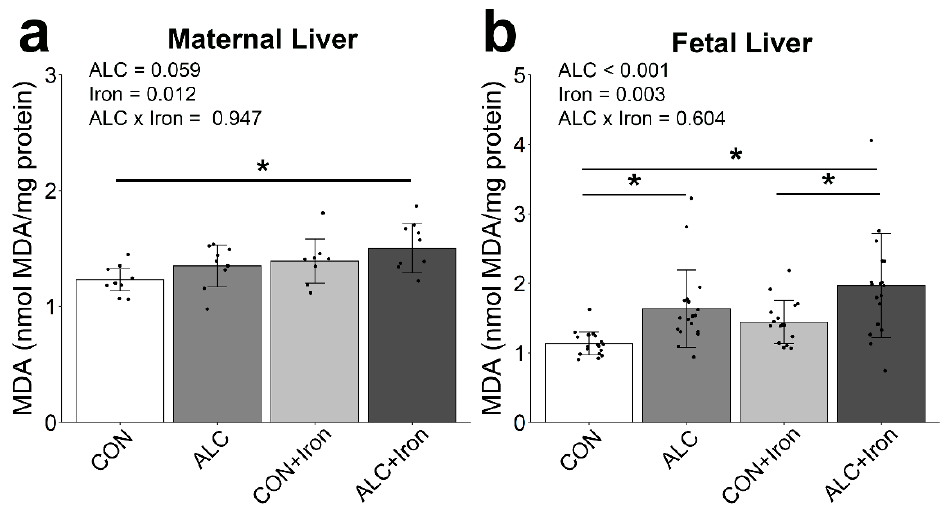
Figure 7. Alcohol exposure and iron supplementation modestly elevate MDA content in maternal and fetal liver. MDA content was quantified in maternal ( a ) and fetal ( b ) livers at gestational day 20.5. n = 8–9 litters per group, sampling 1 dam, 1 male, and 1 female per litter. Data points (black dots) show results for individual animals, while bars show group means ± standard error. For fetal liver, male and female data were combined because there was no effect of sex. Data were analyzed by two-way ANOVA and Tukey’s post hoc test. An asterisk denotes a significant difference at * p < 0.05. Abbreviations: ALC, alcohol exposed; CON, control; MDA, malondialdehyde.